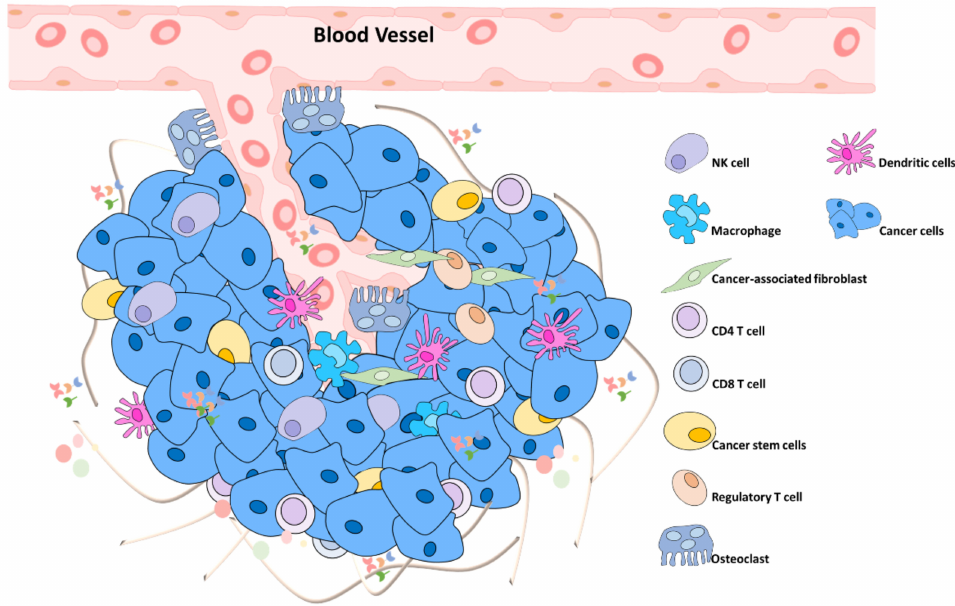
Figure 4. Primary tumor. The tumor microenvironment contains tumor stem cells and tumor- associated extracellular components, such as immune cells. Mainly, cancer cells, such as tumor- associated macrophages, tumor-associated adipocytes, tumor endothelial cells, and tumor-associated fibroblast, can change the characteristics of neighboring cells in various ways and further interact with each other to increase the degree of tumor